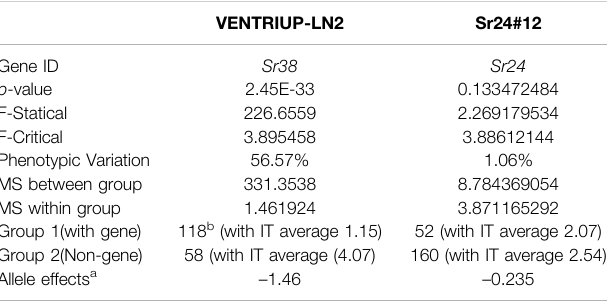
TABLE 2 | Single marker analysis for stem rust resistance in the tested genotypes explained by marker VENTRIUP-LN2 for Sr38 gene and STS marker Sr24#12 for